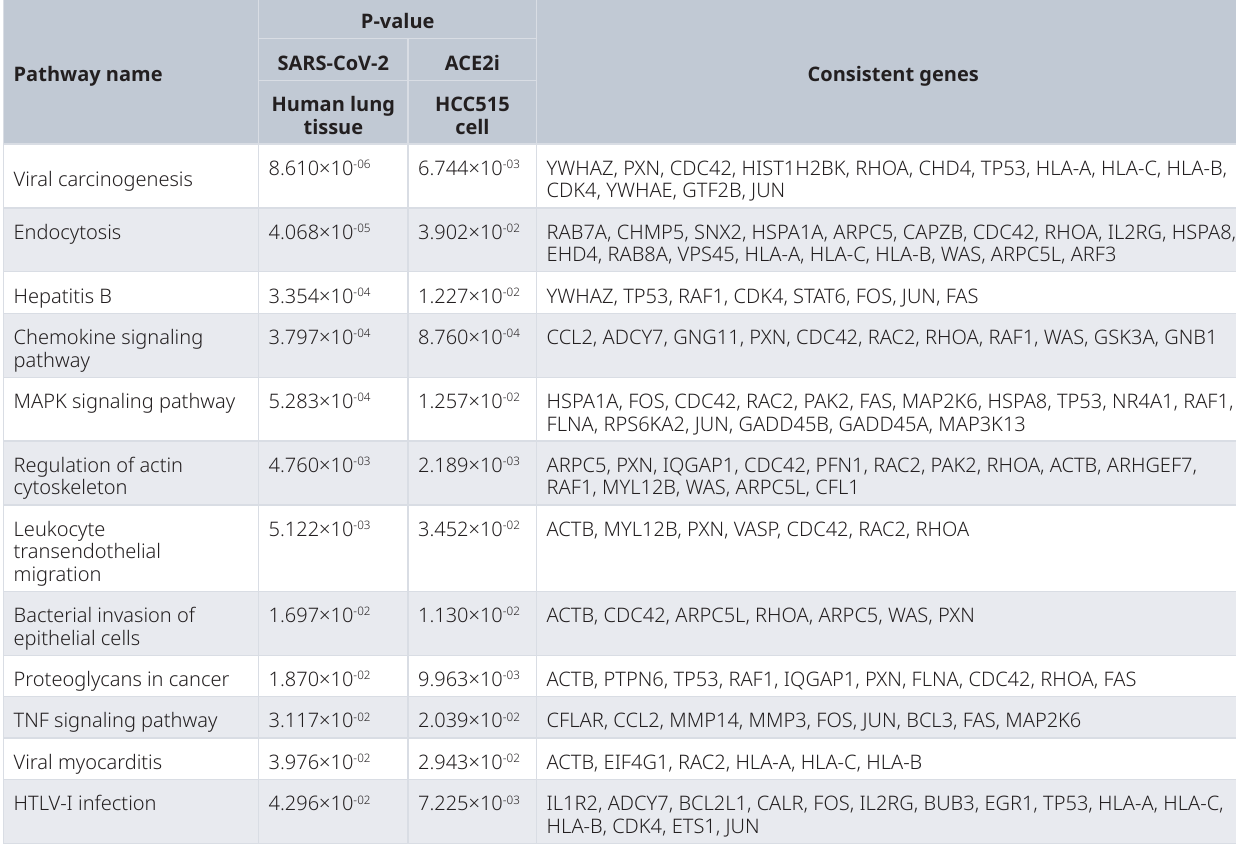
Table 2. Pathway comparison between HCC515 cells with ACE2 inhibitor inhibition and human COVID-19 patient lung tissues.